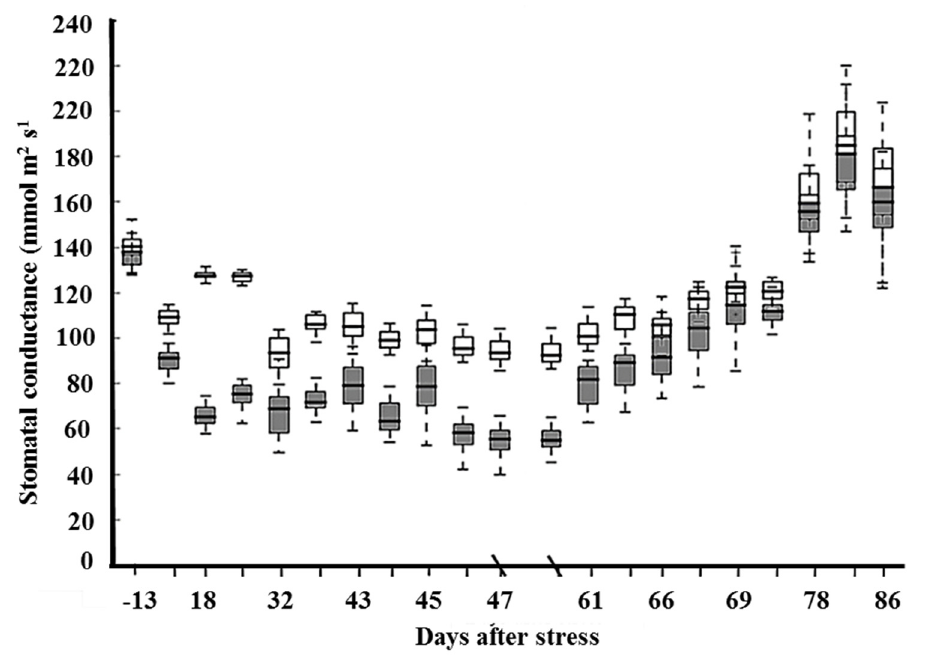
Figure 3. Change in stomatal conductance measured over time. The shaded boxes are the stress treatment, and the open boxes are the control group. The horizontal lines within the box represent the median value, while the top and bottom of the boxes represent the 75th and 25th percentiles. The vertical lines extending beyond the boxes represent the 90th and 10th percentiles. The break in the horizontal axis between 47 and 52 days after stress separates the period of water stress from recovery; n =